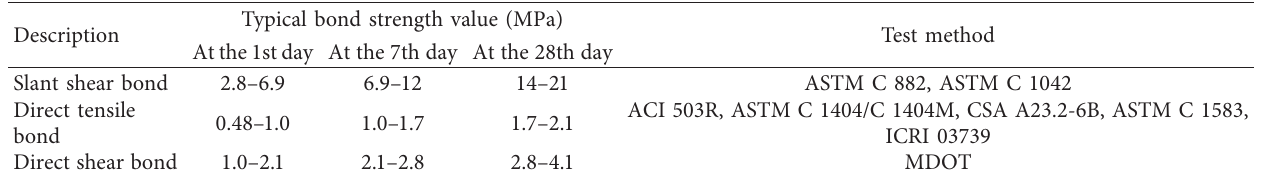
Figure 2: Test specimens. (a) Direct tension. (b) Push-out. (c) Slant Table 4: Summary of available test methods and test values for concrete replacement materials.